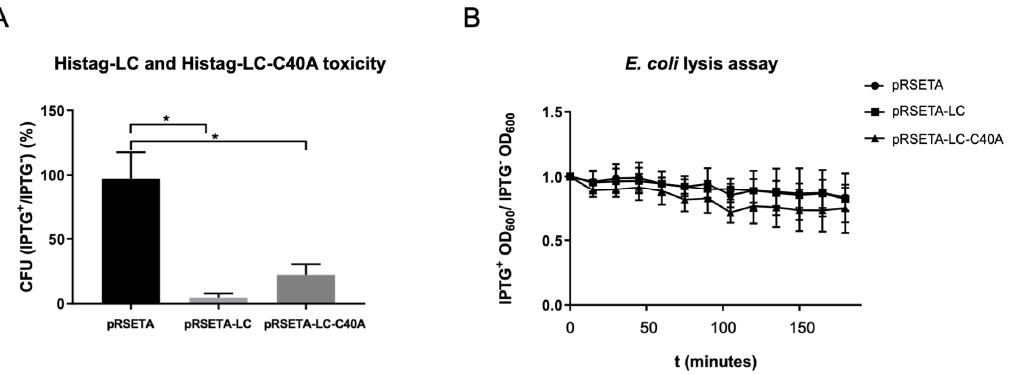
Figure 4. WT-LC and mutant LC-C40A from FCV are intrinsically toxic. ( A ) Overnight cultures of transformed E. coli bacteria with pRSET-A, pRSET-A-LC, or pRSET-A-C40A plasmids were serially diluted until they reached 1:2 × 10 − 6 and were plated in LB + agar with or without IPTG. Colonies for each plate were counted and ratios between colonies with and without IPTG were calculated for each transformed bacteria condition. Standard deviations were obtained from duplicates of at least three independent assays. Values of p ≤ 0.005 (*) of multiple student’s t -tests were calculated using GraphPad Prism 7. ( B ) Changes in the OD 600 after Histag-LC or Histag-LC-C40A induction in E. coli bacteria. Transformed E. coli cells were grown in 96-well plates and half of them were induced with IPTG 1 mM when they reached a 0.4 OD 600 . Plate readings of OD 600 were done every 15 min for a total of 3 h and a comparison of the induced versus non-induced bacteria and statistical analysis was done with Graphpad Prism 7, with no statistical significance found for the two-way ANOVA test.